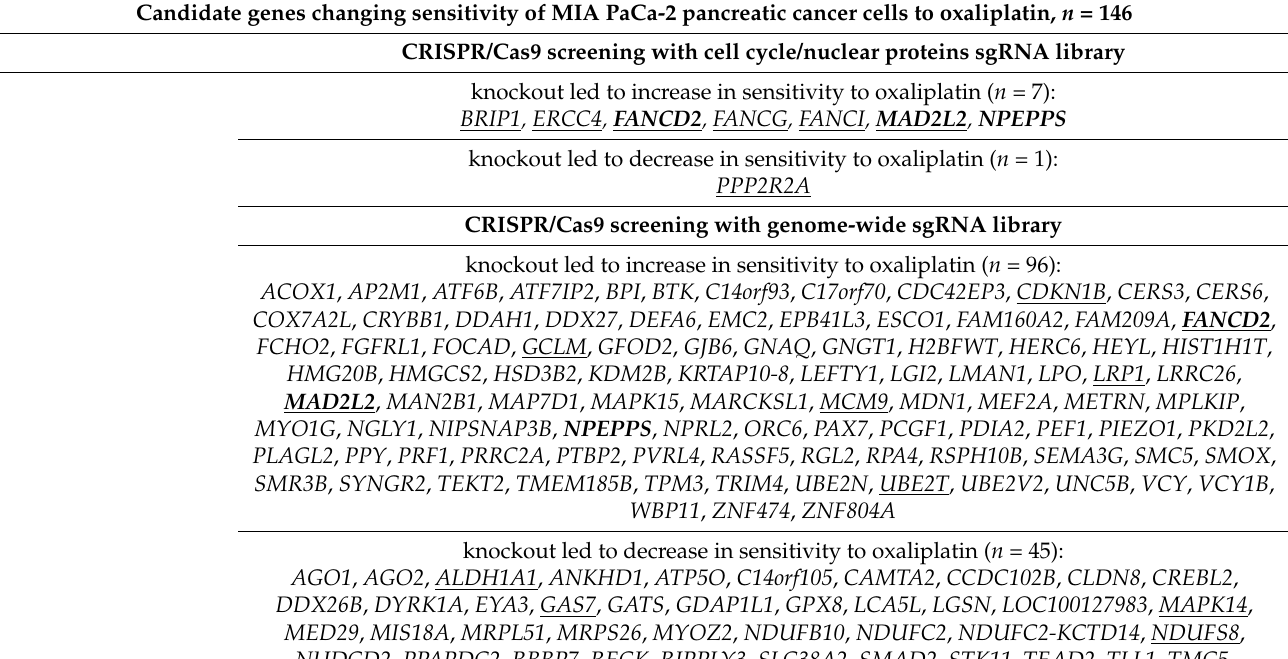
Table 2. Candidate genes changing sensitivity of MIA PaCa-2 pancreatic cancer cells to cisplatin or oxaliplatin according to results of the individual CRISPR/Cas9 screenings with cell cycle/nuclear proteins and genome-wide sgRNA libraries (showing genes for which at least 2 sgRNAs changed representation in ≥ 2 folds, FDR (false discovery rate) ≤